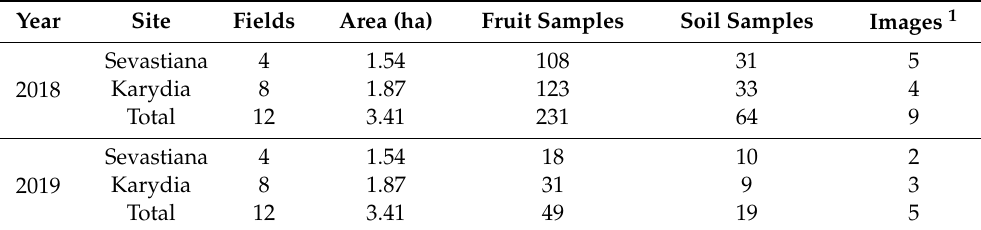
Table 1. Overall figures of experimental data